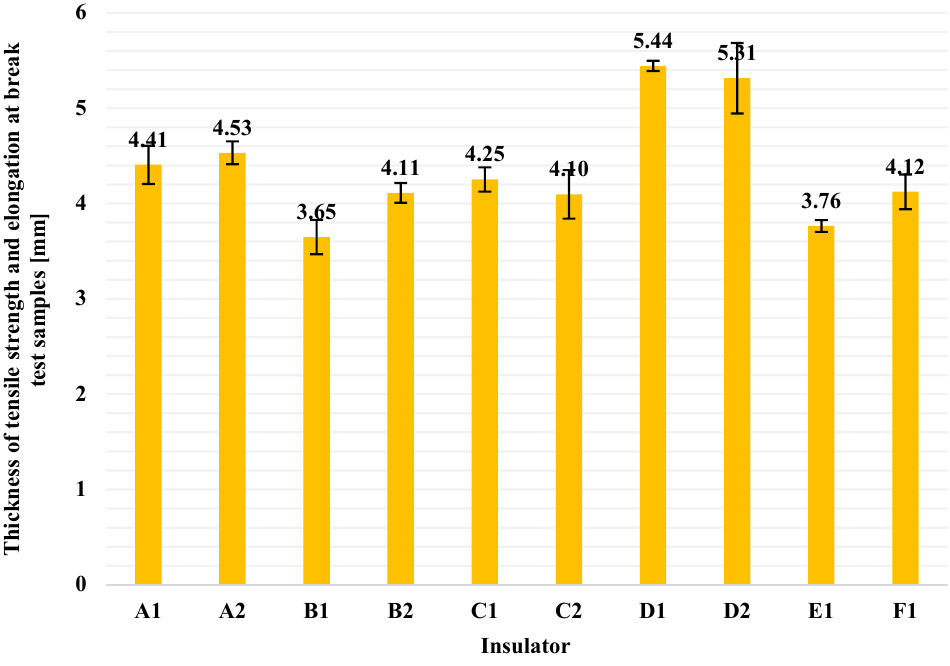
Figure 6. Average thickness values of each pack of five samples (columns) and the corresponding standard deviations (error bars) used for tensile strength and elongation at break test.